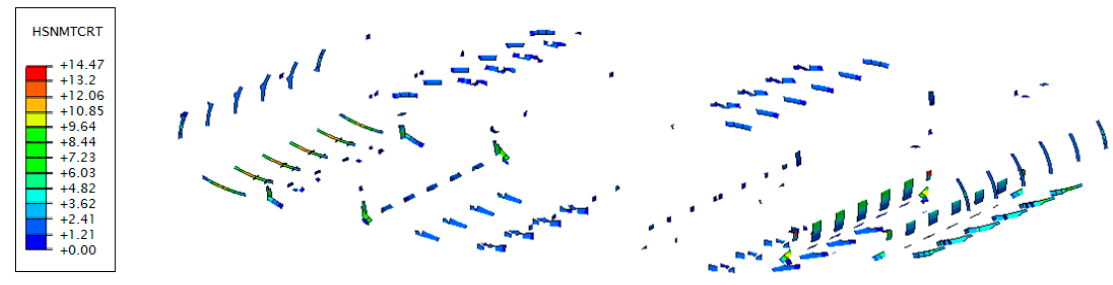
Figure 10. Damaged elements for matrix failure criteria under compression in configuration 1.